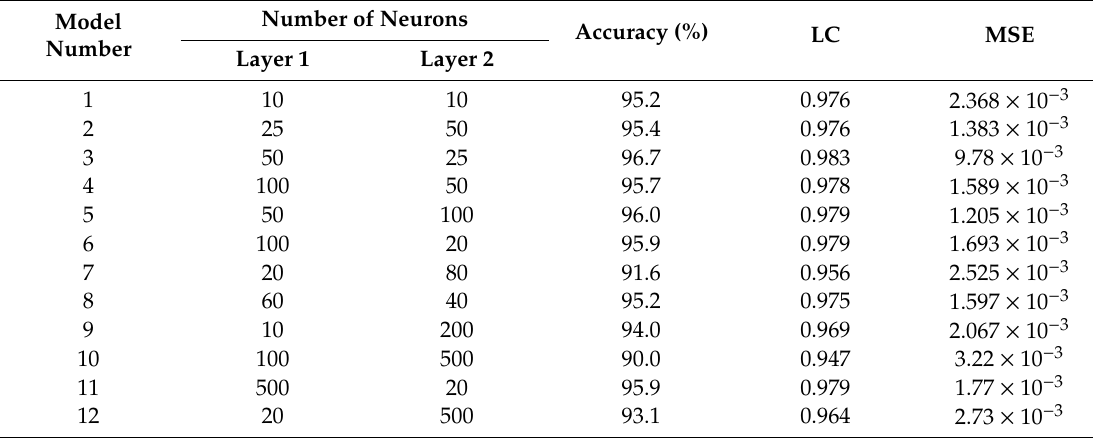
Table 1. Prediction results using an interval of May 2 at 10:08:06 and ended on the May 10 (based on validation partition).